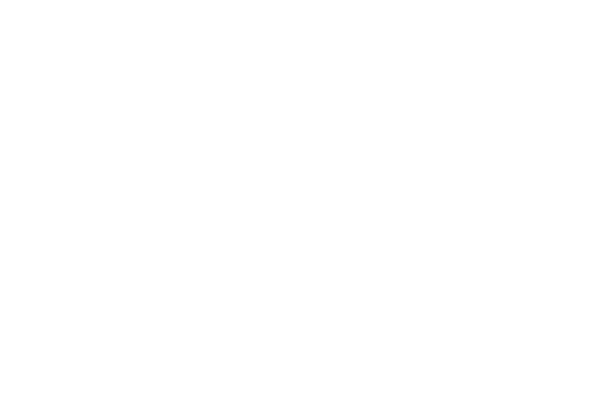
Figure 8. Cell apoptosis assay. Apoptosis assay on FMCm treated with HFn(DOX) or DOX alone at concentrations of 0.1 µM and 0.01 µM for 48 h (black) and 72 h (gray). HFn(DOX) caused more apoptosis than DOX alone 72 h after treatment at 0.1 and 0.01 µM.